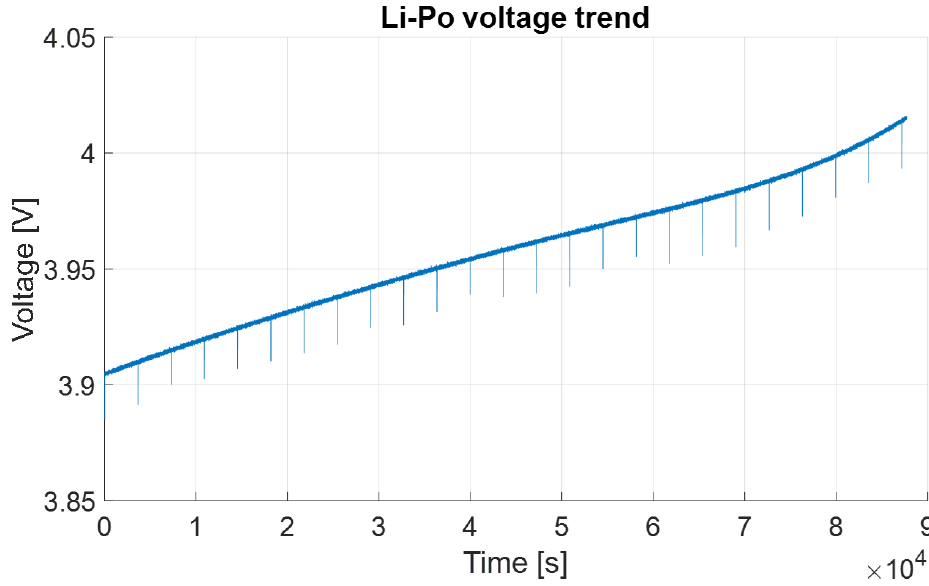
Figure 6. Li-Po voltage trend with radio transmissions every hour and ∆ T = 30